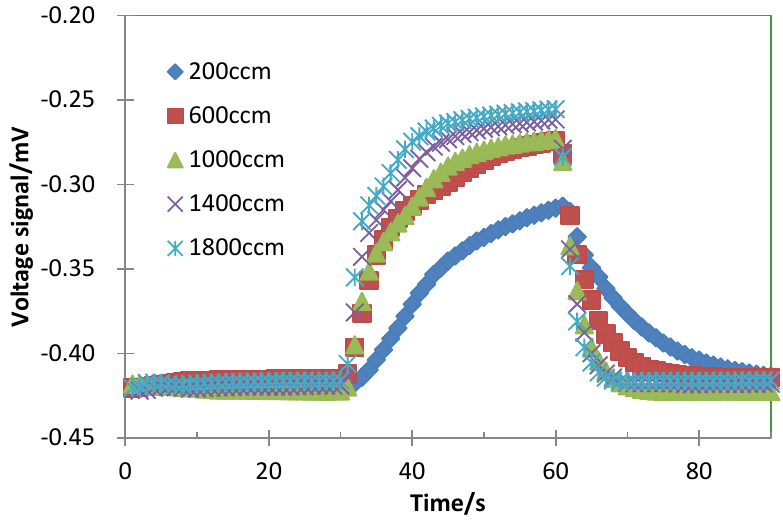
Figure 2. Experimental response curve of the TGS for 200 ppm H and the flow rate from 2 200 ccm to 1,800 ccm. The thermal time constant, measured as the elapsed time from 60 s to decreasing at 63.2% of the  V . The catalyst of the TGS device was heated up to gas 120 °C by its micro-heater. H flow was from 30 to 60 2